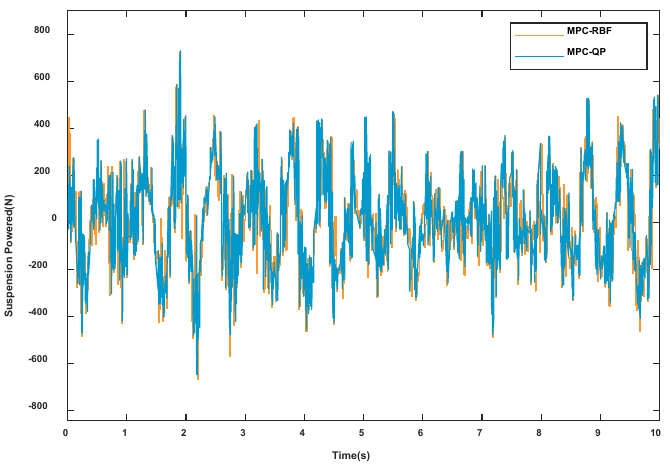
Figure 5. RBF neural network prediction result graph.